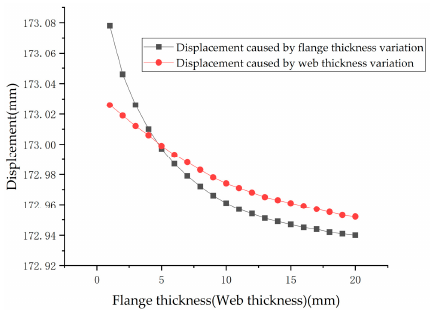
Appl. Sci. 2019 , 9 , x FOR PEER REVIEW Figure 11. Sensitivity curve of C M height and width. Figure 11. Sensitivity curve of C M height and width.